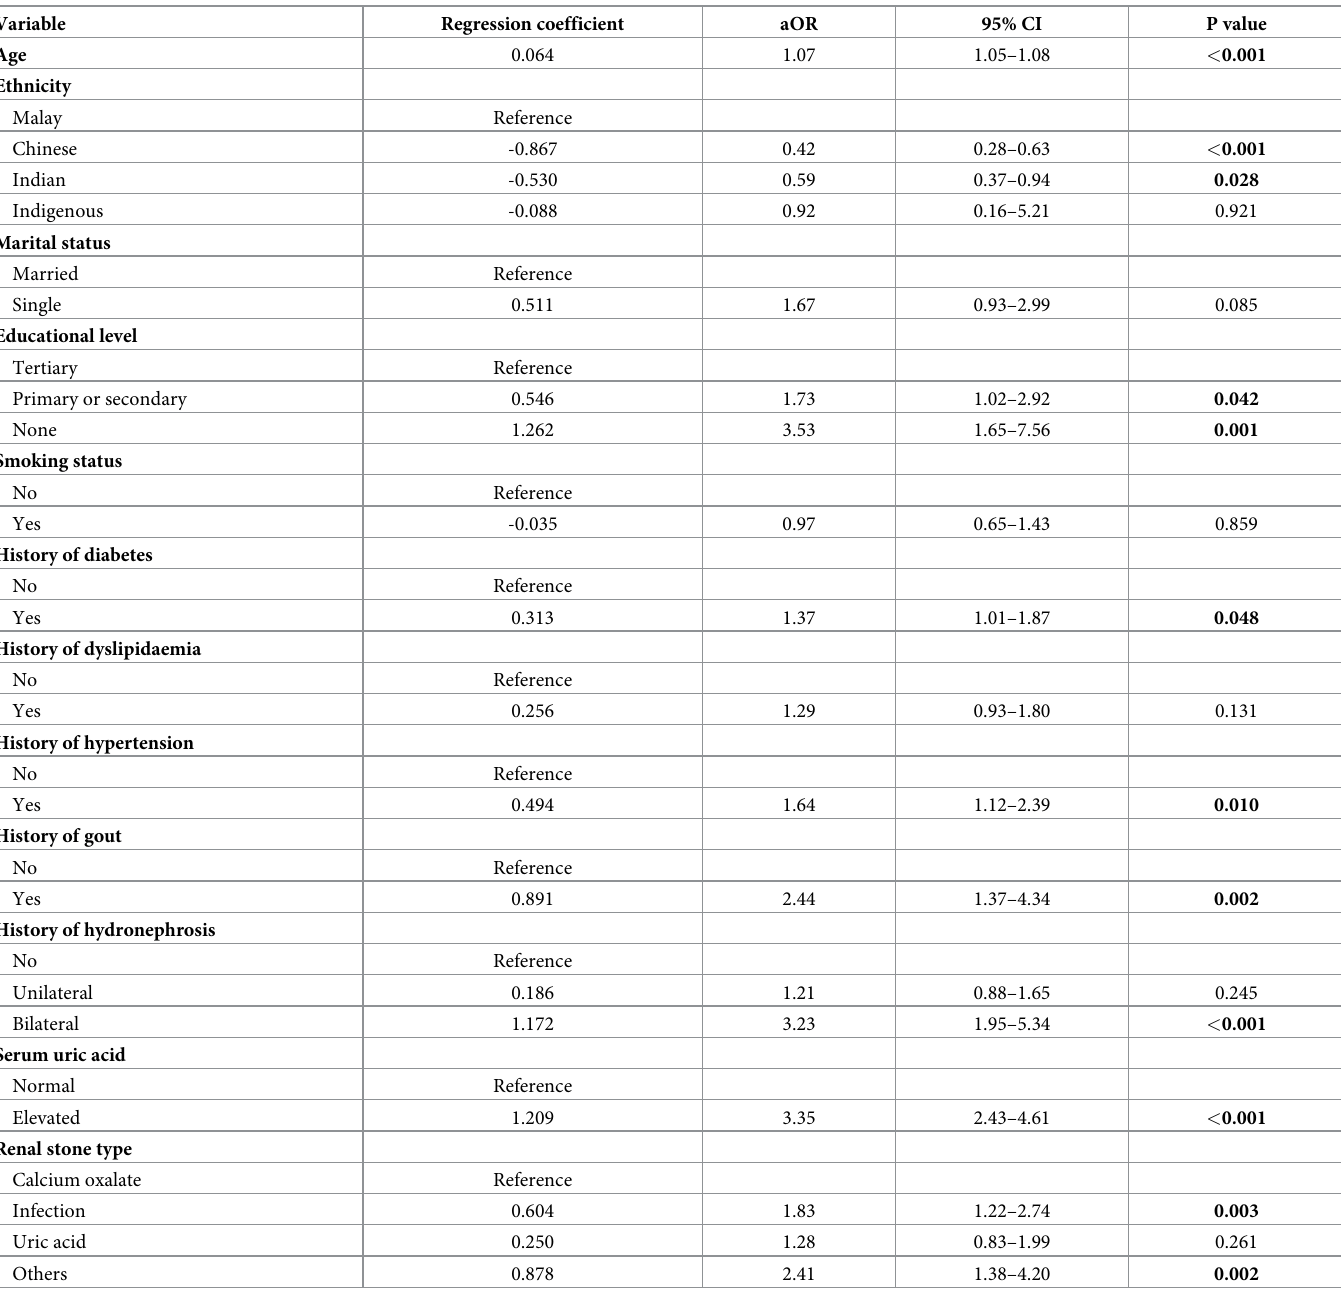
Table 3. Multivariable analysis of factors associated with reduced renal function (eGFR < 60 ml/min/1.73m 2